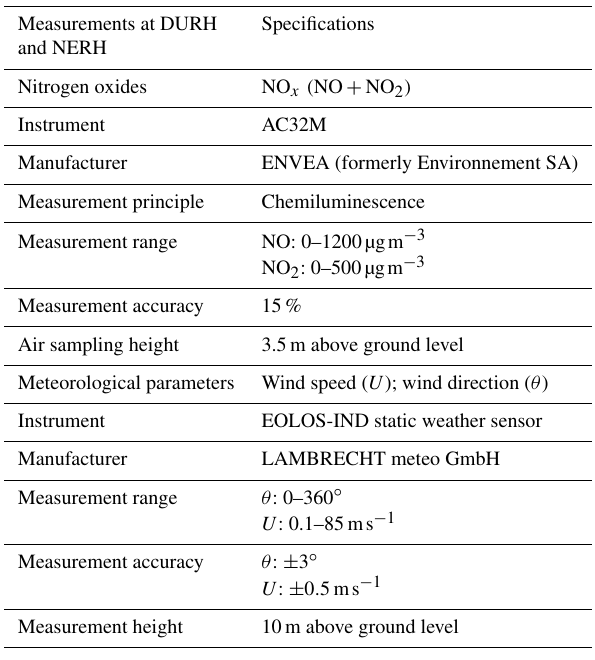
Table 1. Specifications of the instruments